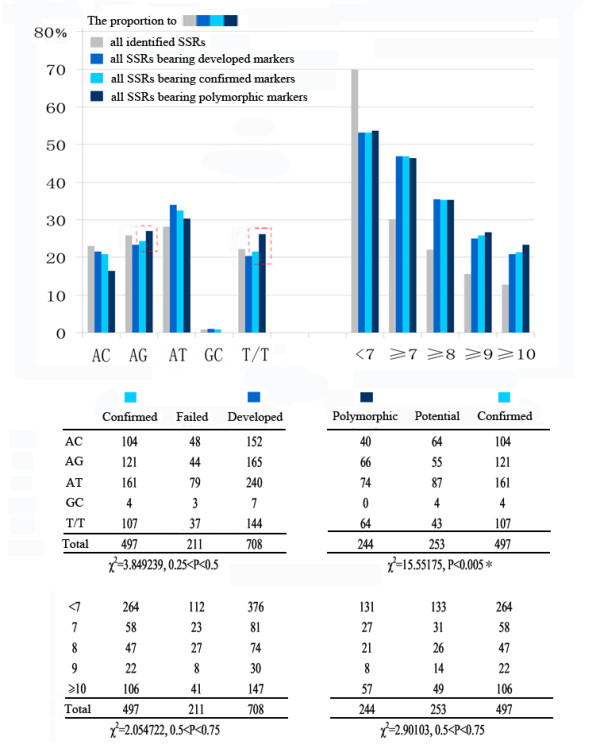
Analysis of the relationship between SSR type and marker efficiency. The enrichment analysis result for each type is shown in the bottom table while the colored bars in the top graph indicate the percentage of each type in the corresponding condition: blue bars indicate the frequency of each type of SSR based on all of the candidate SSRs used for marker development; light blue bars indicate the frequency of each SSR type based on all of the confirmed markers (i.e., those that amplified the product successfully); dark blue bars indicate the frequency of each SSR type to all of the polymorphic markers. A correlative analysis was performed for the four data sets. Our χ2 test results are shown at the bottom of the table; significant correlations are indicated by a star.